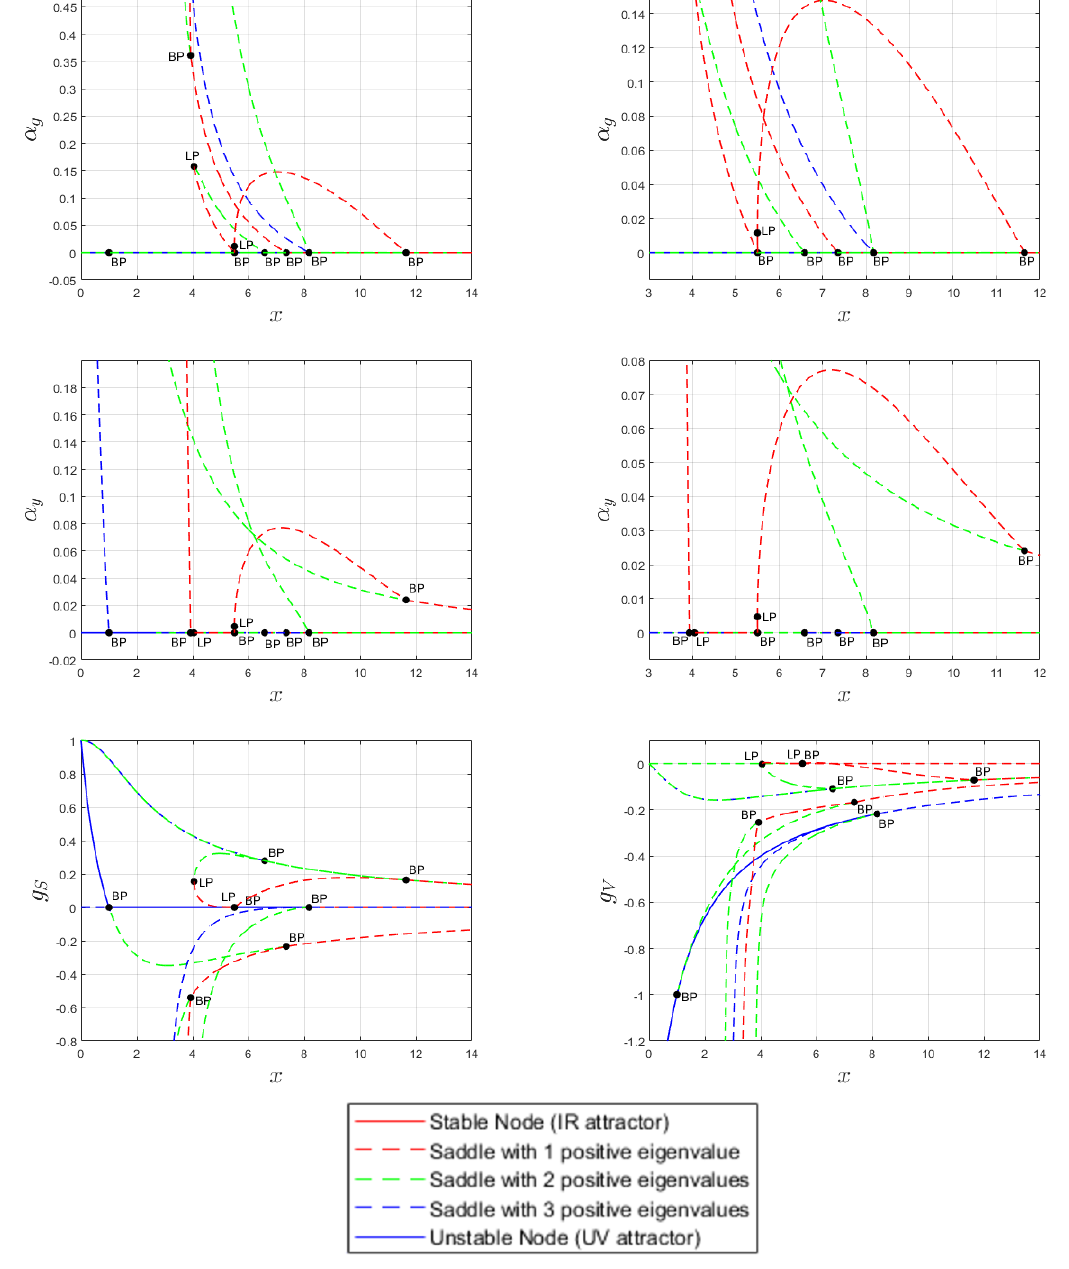
Figure 17. The equilibria of the RG-(cid:13)ow of (3.5) projected on the ( x; (cid:11) ( x; g S )-plane and the ( x; g V )-plane. LP: Limit Point. BP: Branching Point.